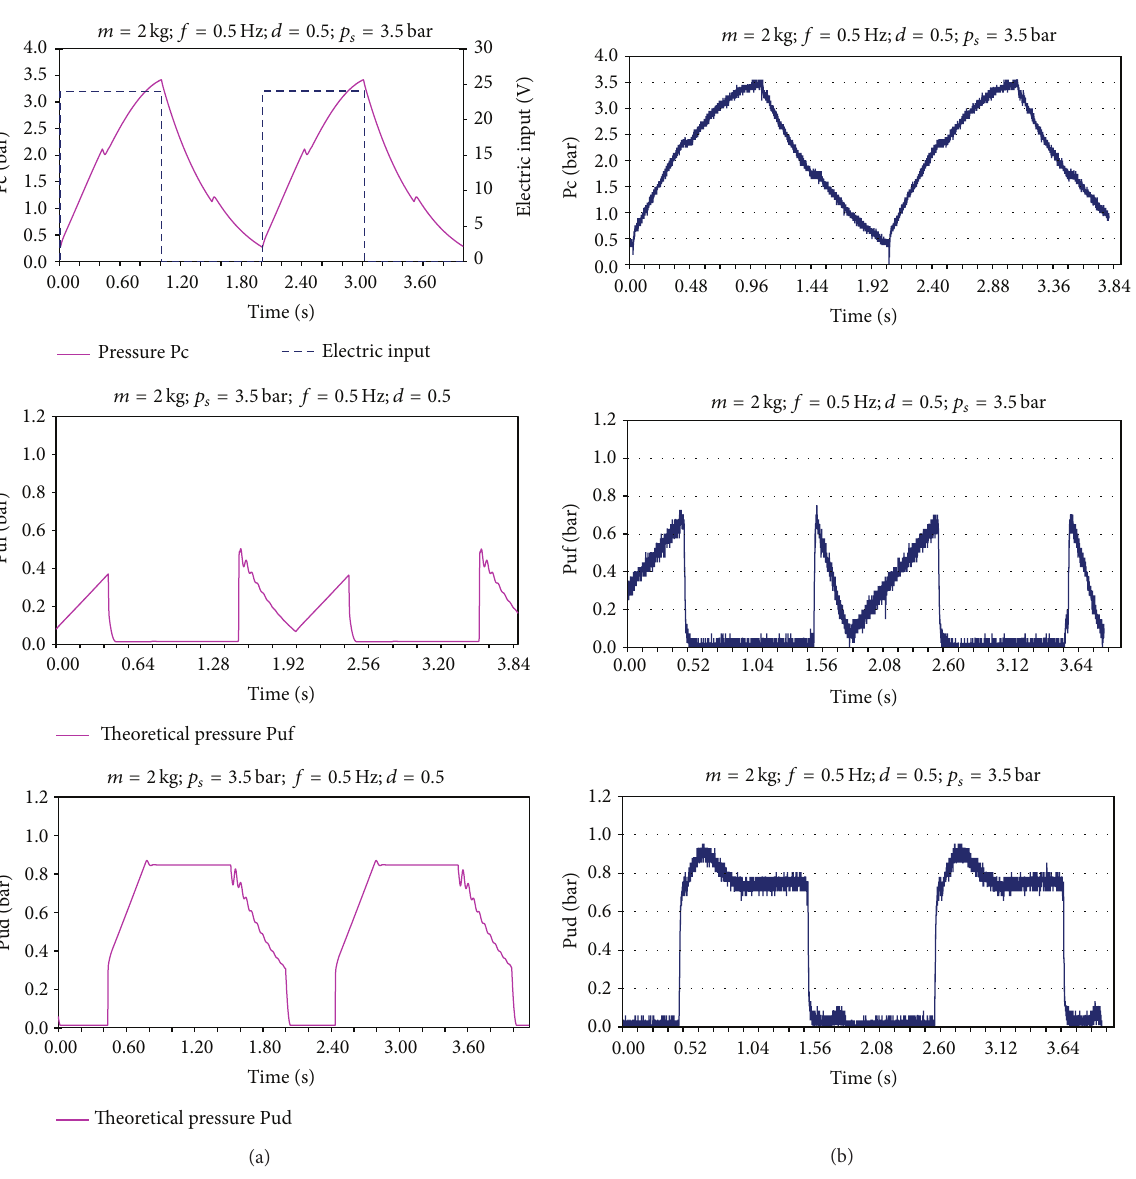
Figure 5: Theoretical (left) and experimental (right) results with 2kg load on actuator, 3.5 bar supply pressure, 0.5 Hz frequency, and 0.25 duty cycle (1 bar = 10 5